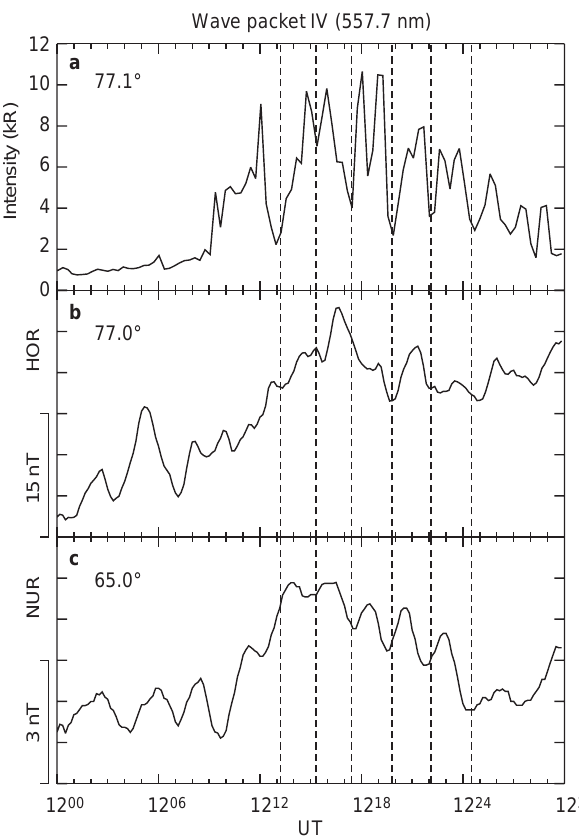
Fig. 8. a Time series of the green line optical intensity at a geographic latitude of 77.1 (cid:176) observed during wave packet IV. Unfiltered X component magnetograms from b a high-latitude (HOR) and c mid-latitude (NUR) station. Vertical dashed lines are added to aid comparison with